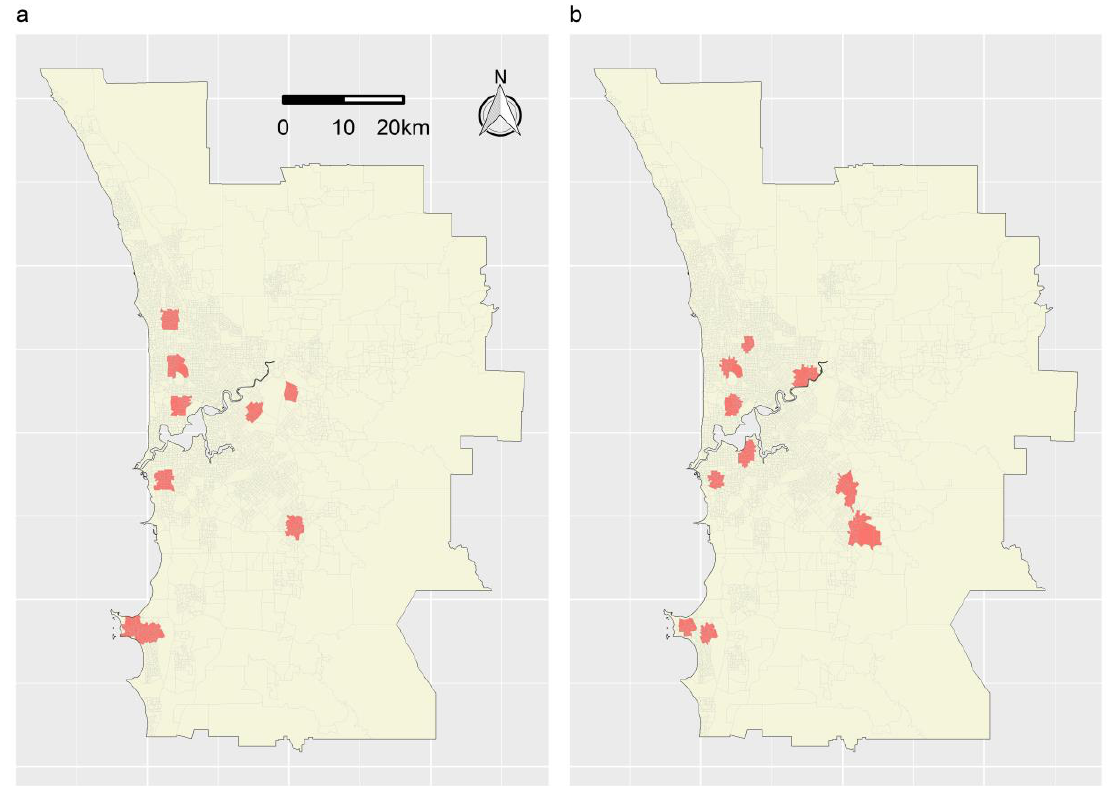
Figure 11a,b map the sets of TRs delineated for stroke using Marxan + MinPatch and the STA, respectively. As expected, given (1) the inverse distance-based weighting function specified for the STA, and (2) that no simulated whittling was applied within MinPatch, the TRs delineated using both methods were relatively compact (while conforming to the somewhat variable shapes of the SA1 boundaries). For Marxan + MinPatch, eight TRs were delineated in total; these contained 15.02% of strokes and 7.58% of the population; thus, their targeting efficiency can be expressed as 1.98% of strokes for every 1% of the population targeted (calculation: 15.02/7.58). By comparison, for the STA, 10 TRs were delineated in total; these contained 16.33% of strokes and 6.59% of the population; thus, their targeting efficiency can be expressed as 2.48% of strokes for every 1% of the population targeted (calculation: 16.33/6.59). These results are consistent with those of the simulation study: the targeting efficiency of the STA was greater than that of Marxan + MinPatch, while the number of TRs was similar.